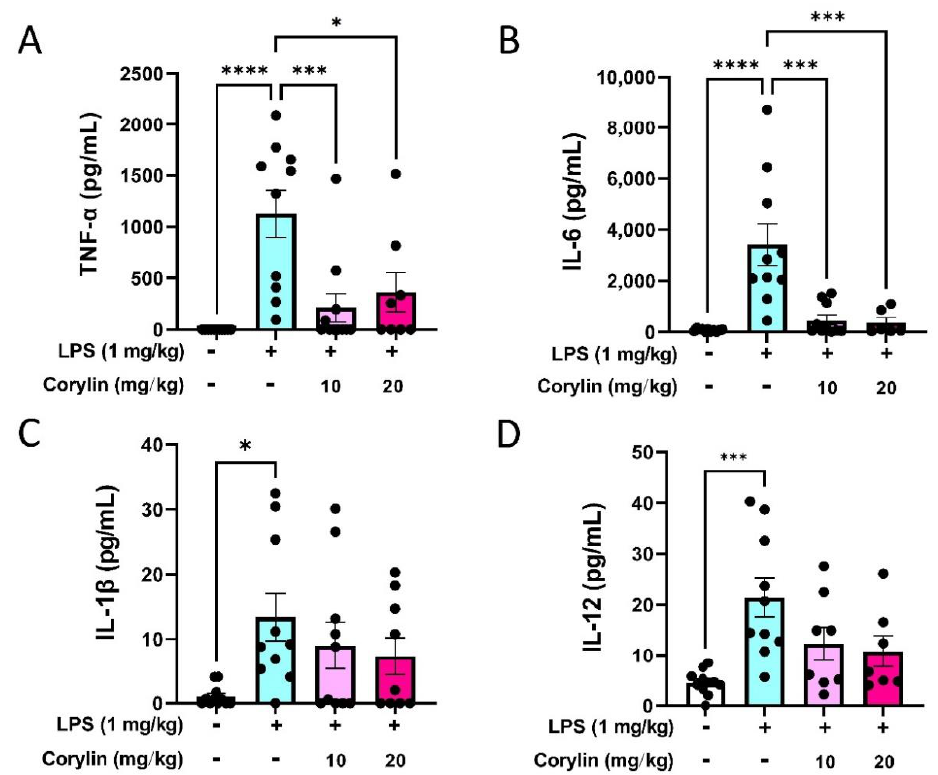
Figure 2. Effects of corylin on LPS-induced inflammatory cytokine productions in BALF. Mice were intraperitoneally injected with corylin (10 mg/kg or 20 mg/kg) for 1 h following intratracheal administration of LPS for 4 h. The mice were sacrificed and the BALF was collected. The expression levels of ( A ) TNF- α, ( B ) IL-6, ( C ) IL- 1β, and ( D ) IL-12 in BALF were analyzed using ELISA. The data are presented as means ± SEM of three independent experiments. Statistical significances are represented as follows: * p < 0.05, and *** p < 0.001 and **** p < 0.0001 vs. LPS alone.